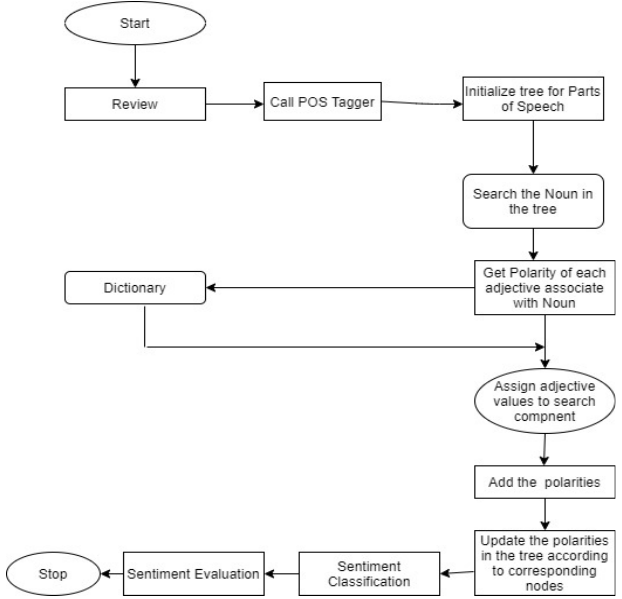
Figur e 2. Flowchart of improvised